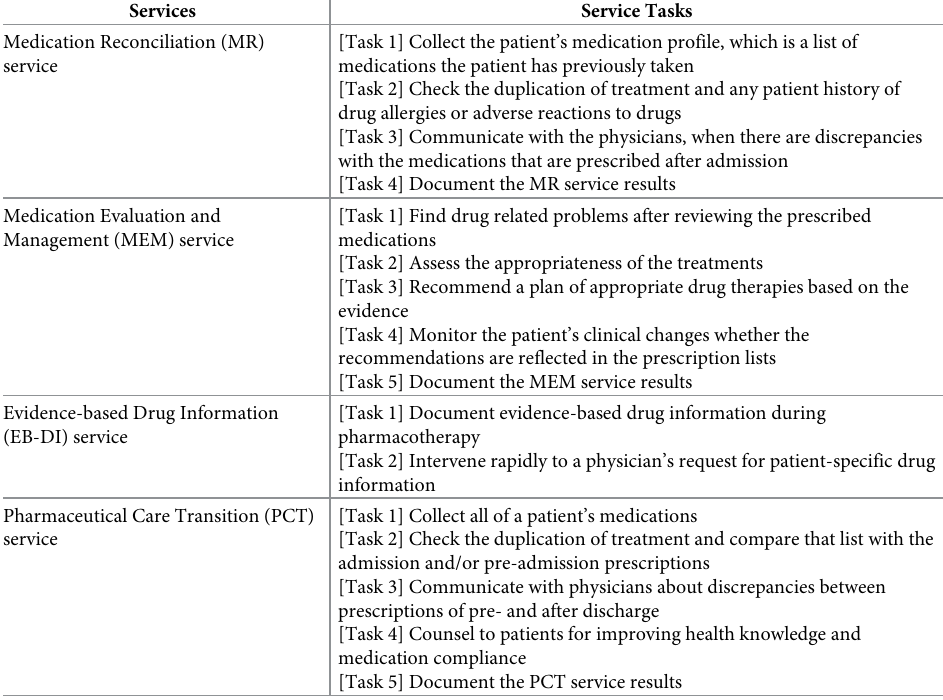
Table 1. Service types and tasks in our collaborative multidisciplinary DrugTEAM service model.